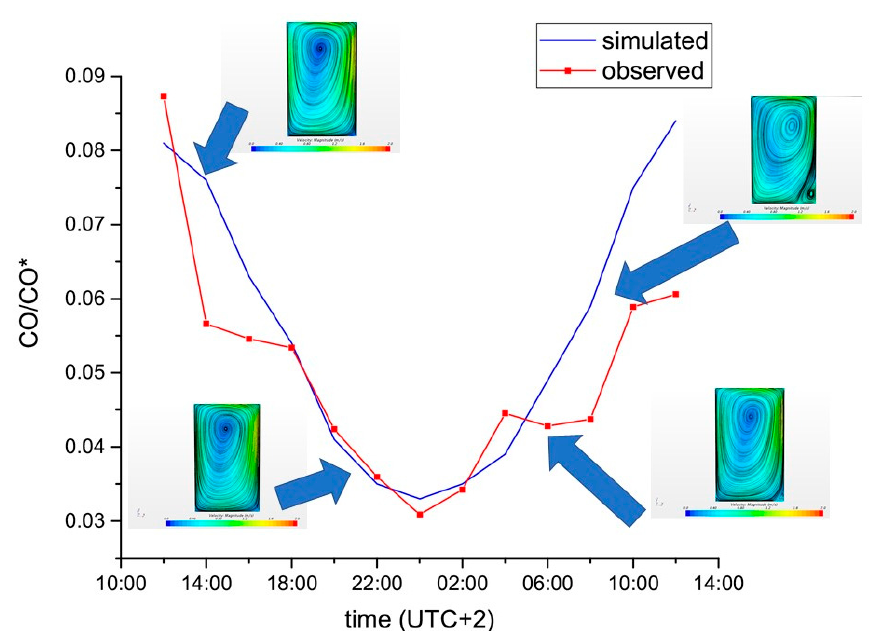
Figure 13. Pattern of observed and simulated normalized CO concentration within a street canyon with AR equal to 1.65 in Computational Fluid Dynamics (CFD) simulations. Also shown are the vortices observed in the CFD simulations.